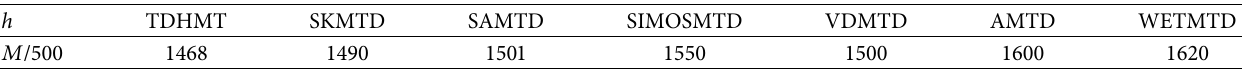
Table 3: Comparison of the NFE of TDHMTwith other existing methods, namely, SKMTD, SAMTD, SIMOSMTD, VDMTD, AMTD, and WETMTD for Example 1.